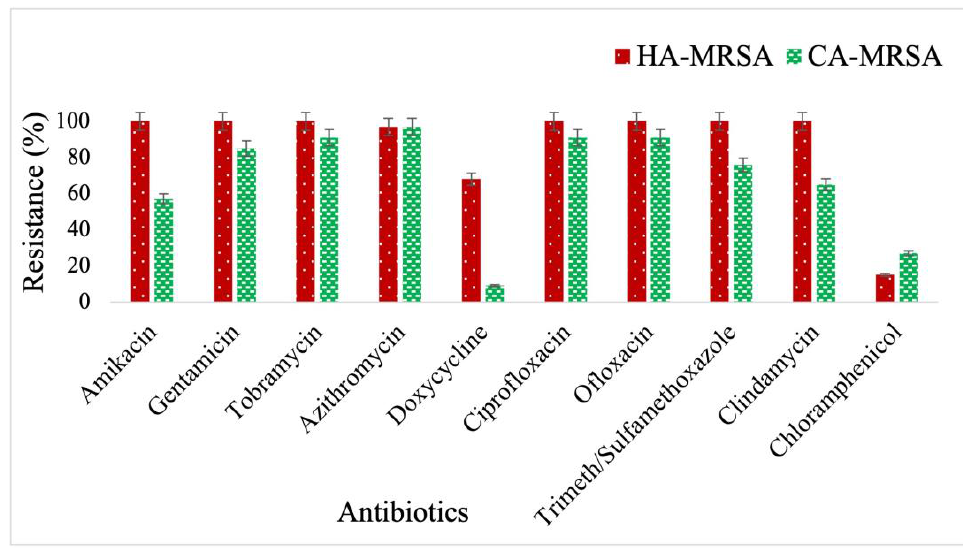
Figure 1. Antibiogram of HA-MRSA and CA-MRSA against recommended antibiotics.